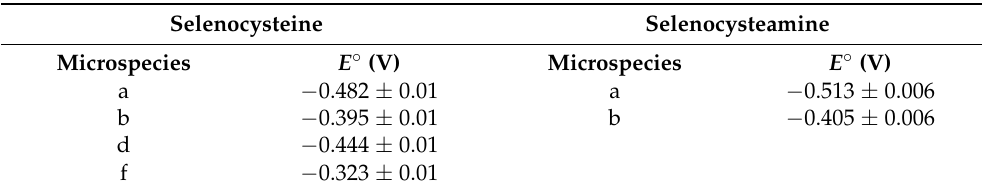
Table 1. Standard redox potential values of selenocysteine and selenocysteamine, specified for their microspecies, along with their standard errors [49].